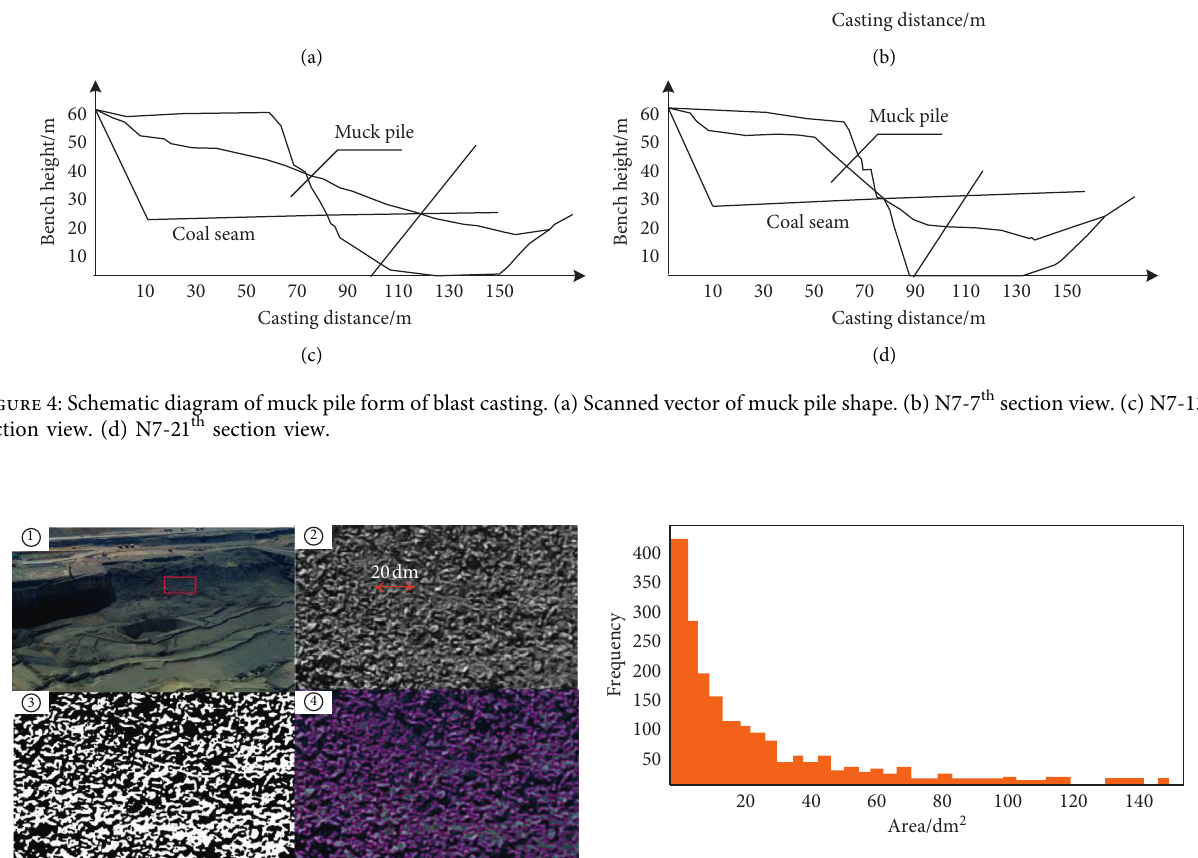
Table 3, evaluation indicators of fragmentation distribution and boulder generation are quantified numerically.